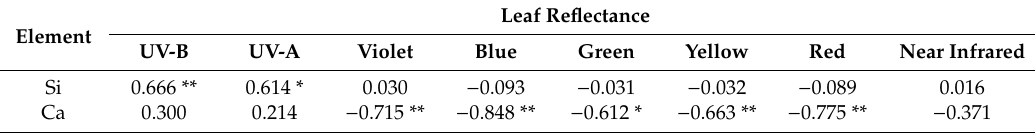
Table 4. Pearson correlations between proso millet leaf reflectance, and leaf silicon and calcium contents. Element